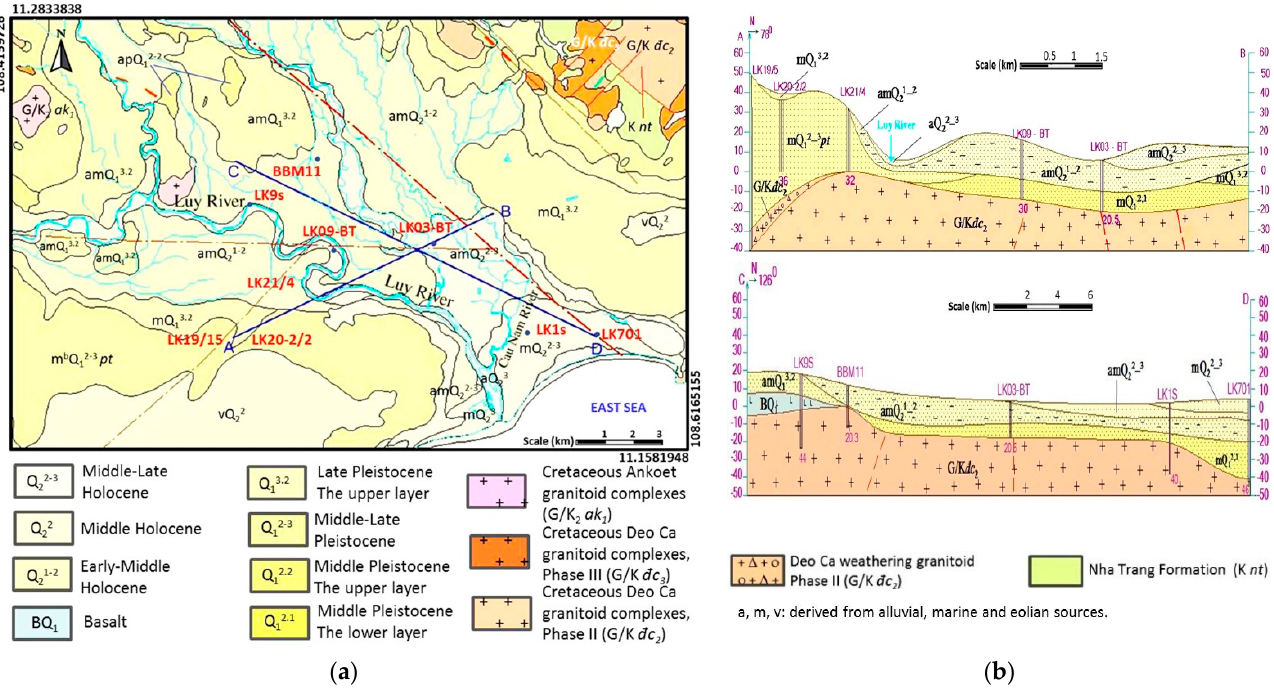
Figure 2. ( a ) Geological map of the downstream part of the Luy River and its vicinity. Three fault systems (the dotted lines) are covered by Quaternary sediments. ( b ) Two geological cross sections: AB and CD are approximatively parallel and perpendicular to the shoreline, respectively.